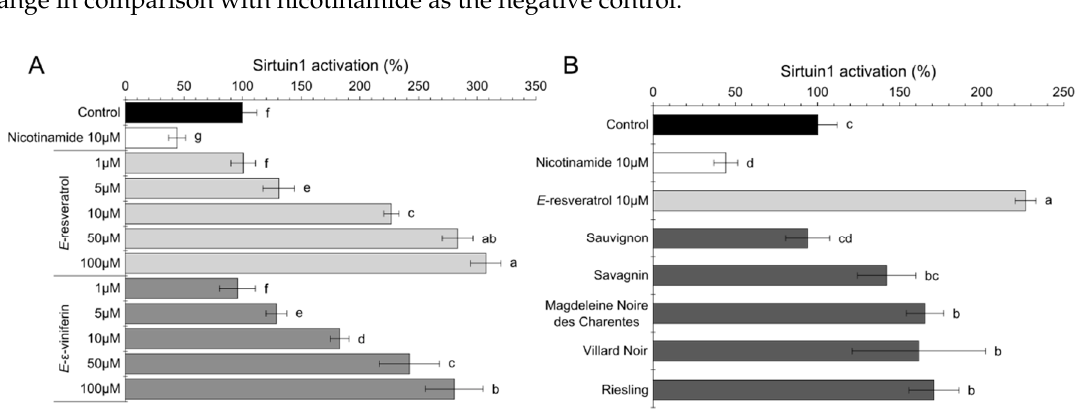
Figure 1. The structures of major polyphenols analyzed in GCE.